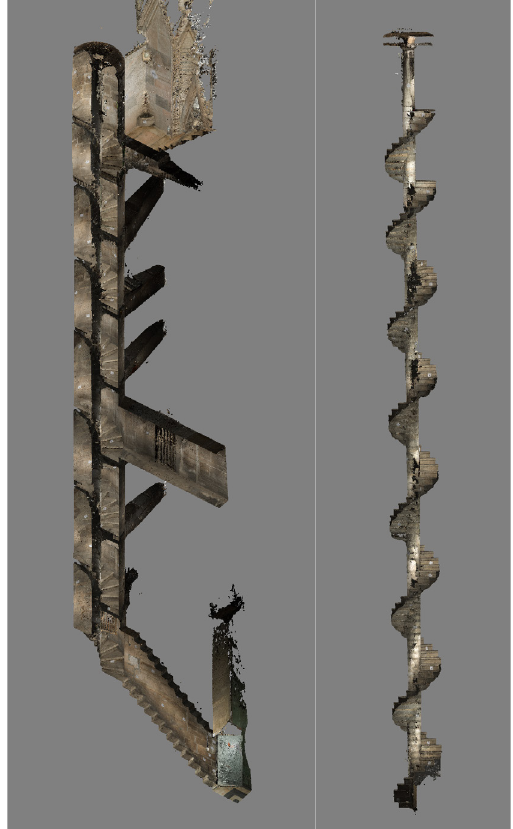
Figure 13. Dense point cloud obtained with the Nikon D810 coupled with 12mm stereographic